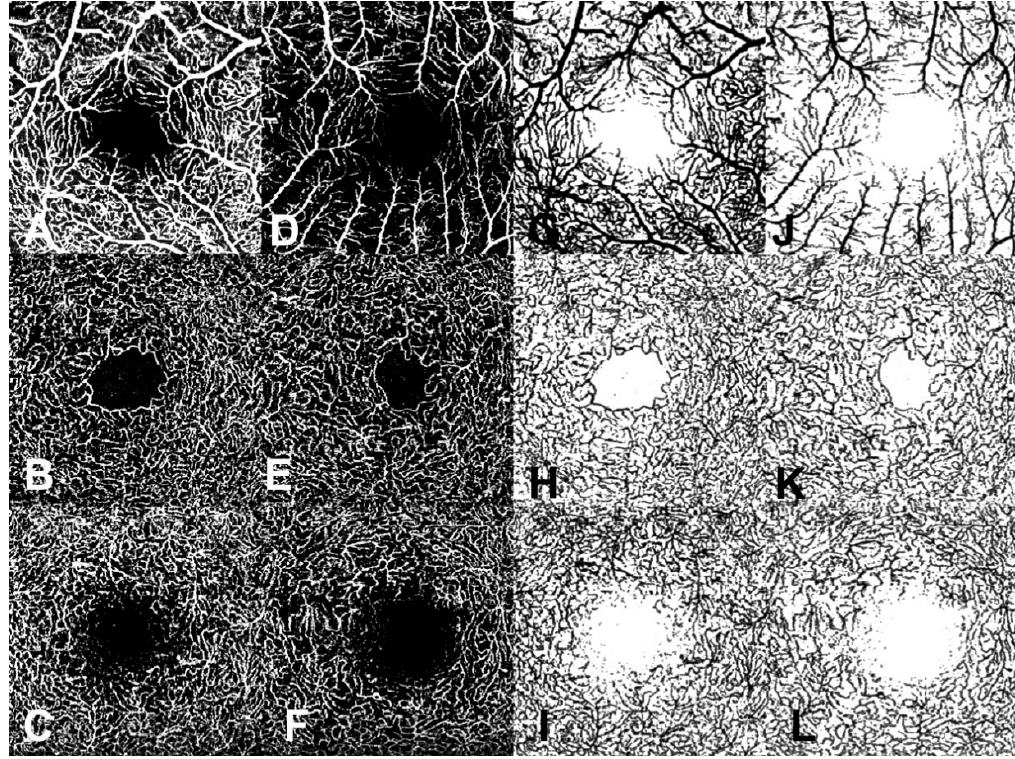
Figure 1. En-face OCT angiography (OCTA) and corresponding binary images of an eye of a Von Hippel–Lindau (VHL) patient ( D – F , J – L ) and of a healthy control ( A – C , G – I ) of the superficial vascular plexus (SVP, A , D ), of the intermediate capillary plexus (ICP, B , E ) and of the deep capillary